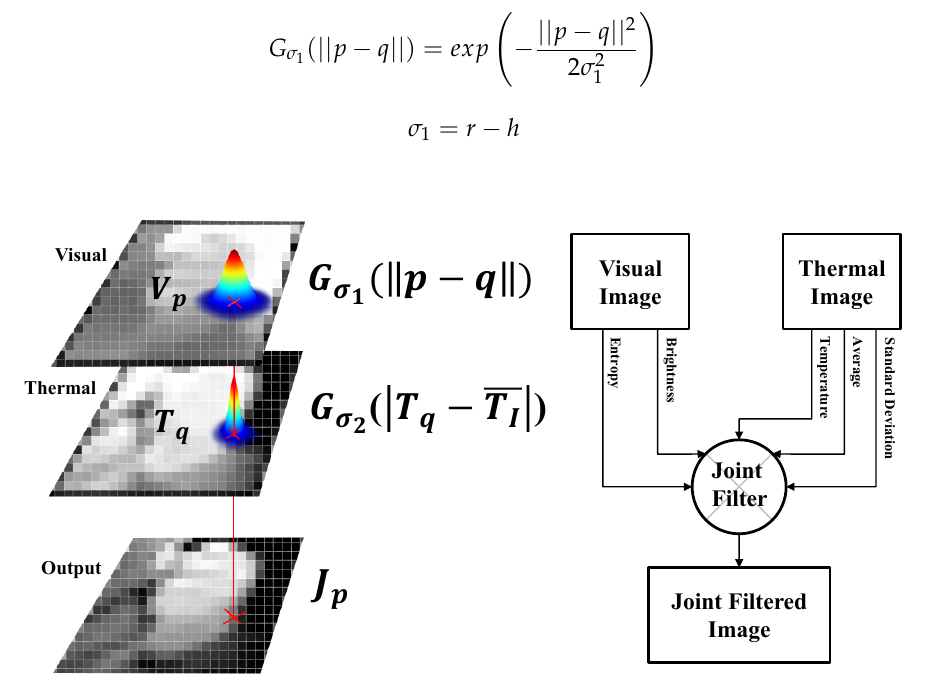
Figure 3. Overall process of our thermal-guided joint